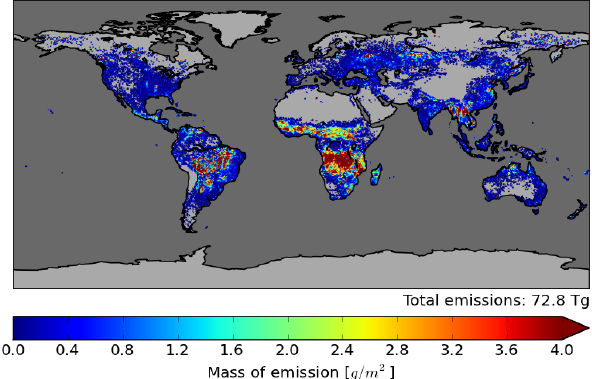
Figure 10. FEER.v1 emissions estimates of total particulate mat- Fig. 10. FEER.v1 emissions estimates of total particulate matter (TPM) for all of 2010 on 1552 ter (TPM) for all of 2010 on a 0.5 ◦ × 0.5 ◦ resolution global grid. a 0.5 ° × 0.5 ° resolution global grid. These values are generated from Eq. (2), using the 1553 These values are generated from Eq. (2), using the FEER.v1 C e FEER.v1 C e product in conjunction with FRE data derived by multiplying the GFAS.v1 1554 product in conjunction with FRE data derived by multiplying the monthly average FRP data by the total number of days in each month. 1555 GFAS.v1 monthly average FRP data by the total number of days in each month.